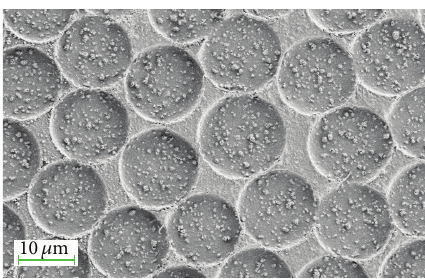
Figure 7: Field emission scanning electron microscopy image of the PLGA/3Ag nanocomposite film, modified by plasma oxygen